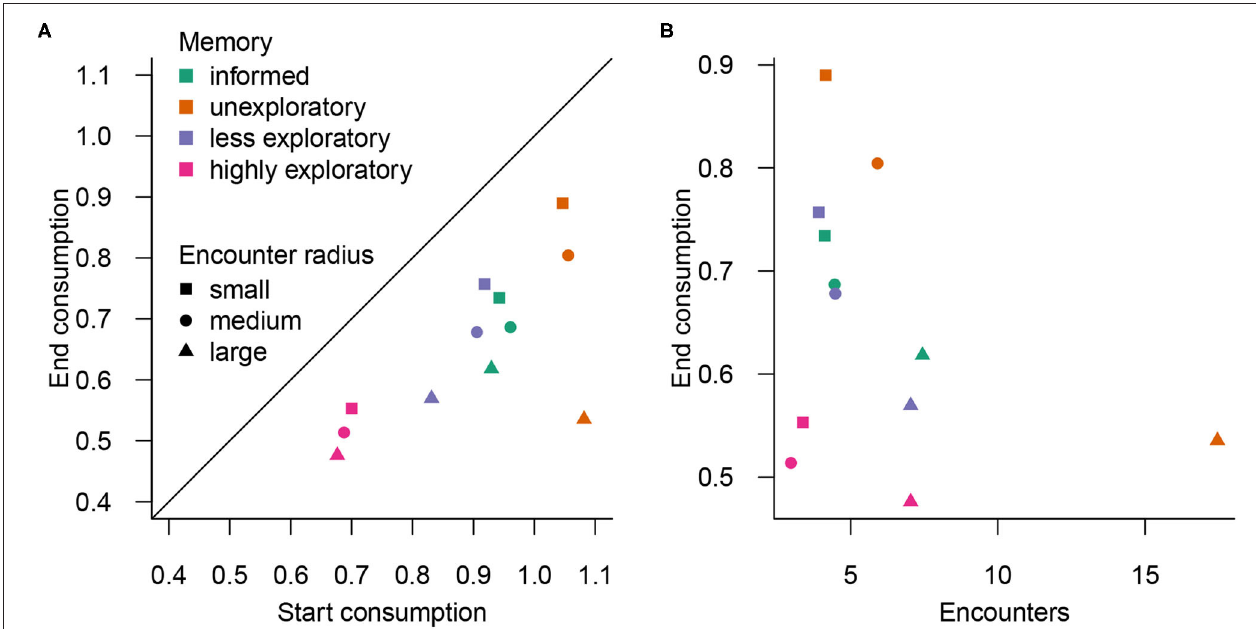
FIGURE 3 | (A) Consumption in the post-predator environment declined in all scenarios compared to the pre-predator environment (i.e., prior to introduction), but was influenced by memory state and encounter radius. (B) Higher encounters generally also led to decreased consumption in the post-predator environment. Memory state is indicated by color and encounter radius by